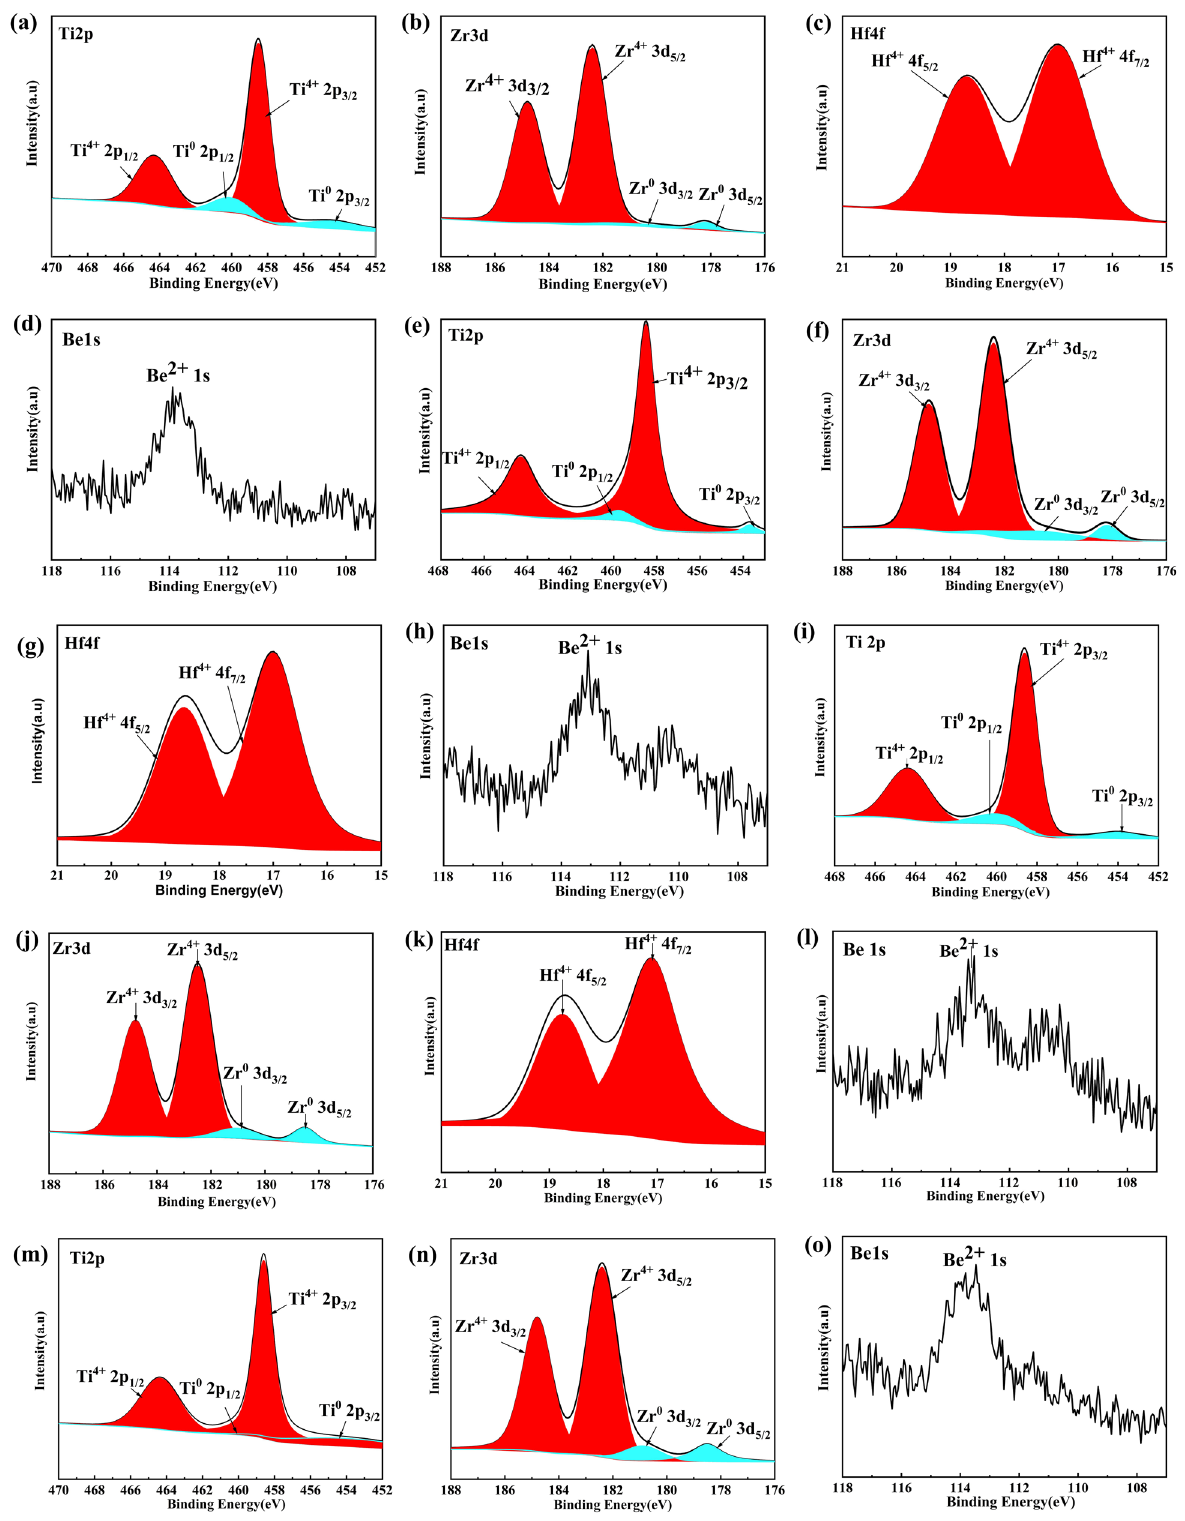
Fig. 6 XPS spectra of the outermost surfaces (without Ar-ion etching) of the samples after immersion in NaCl solution for 2 days. a – d TC sample, e – h TCN sample, i – l TN sample, and m – o Vit1 sample.